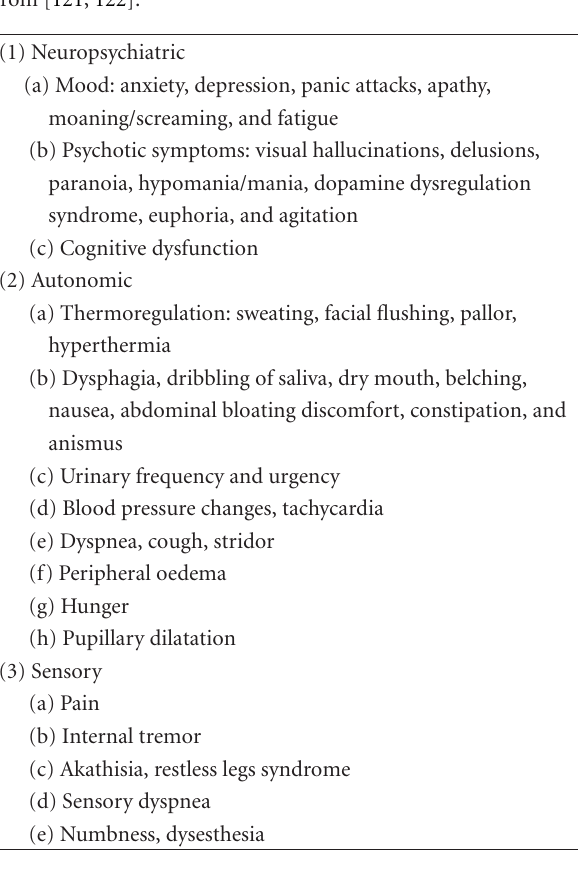
Table 3: Nonmotor fluctuations in Parkinson’s disease (modified from [121,